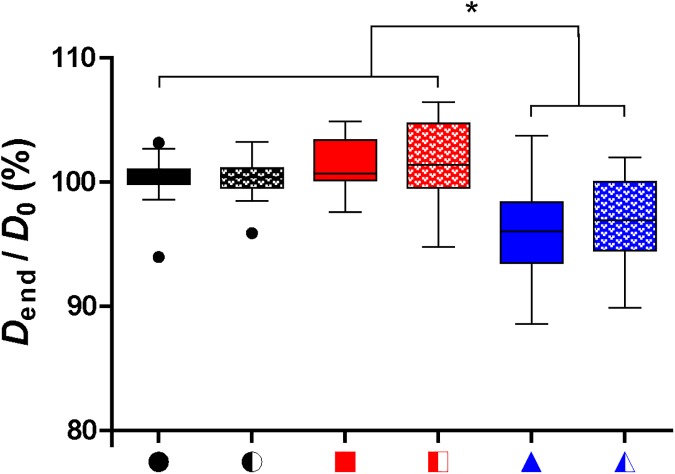
Relative microbubble diameter after insonification.Combination of microbubbles insonified at a frequency of 0.5 MHz and P_ of 25 and 50 kPa and frequency of 1 MHz and P_ of 50 kPa; * indicates significant difference; for the symbols on the x-axis, see the rightmost column of Fig 2 and Fig 3.